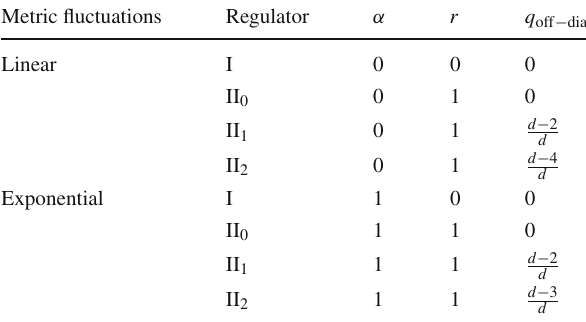
Table 1 Parameter sets used in analyzing the dynamics encoded in the beta functions (29). The value q off − diag specifies the endomorphism in the ˆ N – h sector, where the coarse-graining operator is then given by ¯ (cid:3) = (cid:15) + q off − diag